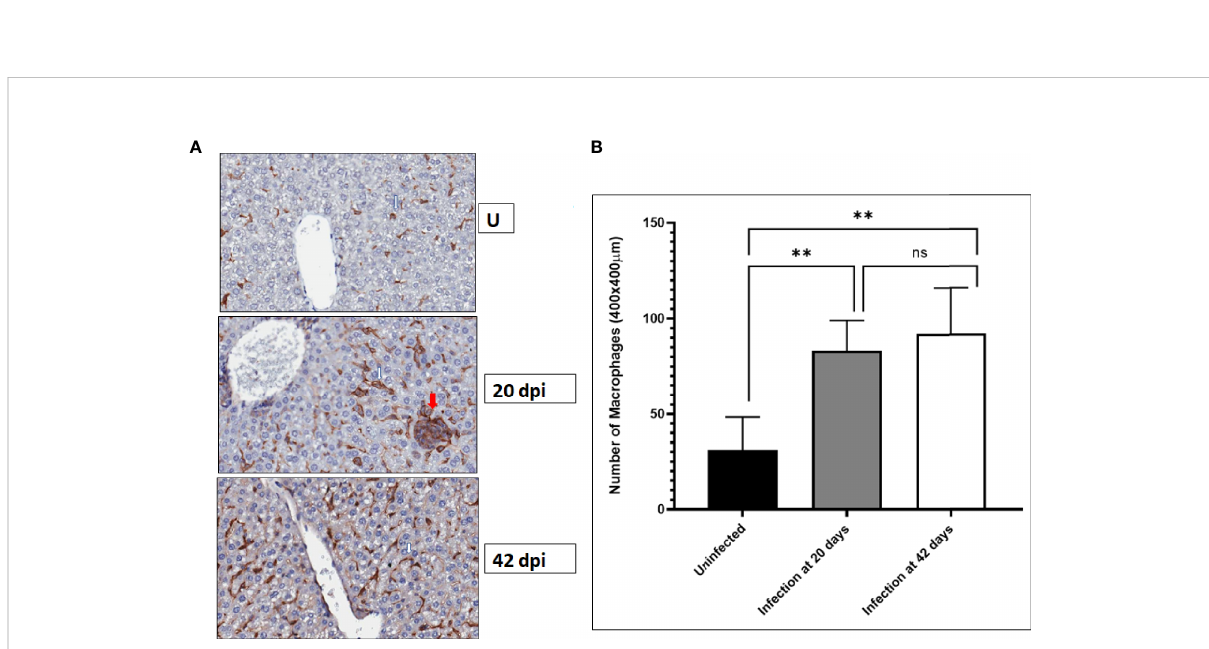
FIGURE 2 F4/80+ macrophages increase in the liver after L. donovani infection. BALB/c mice were infected by tail vein injection of metacyclic L. donovani promastigotes. At the indicated times after infection, the livers of infected and uninfected mice were recovered and fi xed in formalin and paraf fi n embedded. Livers sections were prepared and processed for immunohistochemical labeling. F4/80 positive macrophages were labeled with a primary antibody detected with an HRP-conjugated secondary antibody followed by activity of diaminobenzidine (DAB). The sections were counterstained with hematoxylin. (A) White arrows point to representative F4/80+ labeled cells; red arrows points to a granuloma. (B) F4/ 80+ cells were enumerated in regions randomly selected through the entire liver and plotted in GraphPad. Data was compiled from three mice per group. Student t-test was used to establish statistical signi fi cance. ** p<0.01; ns (not signi fi cant) p>0.05.